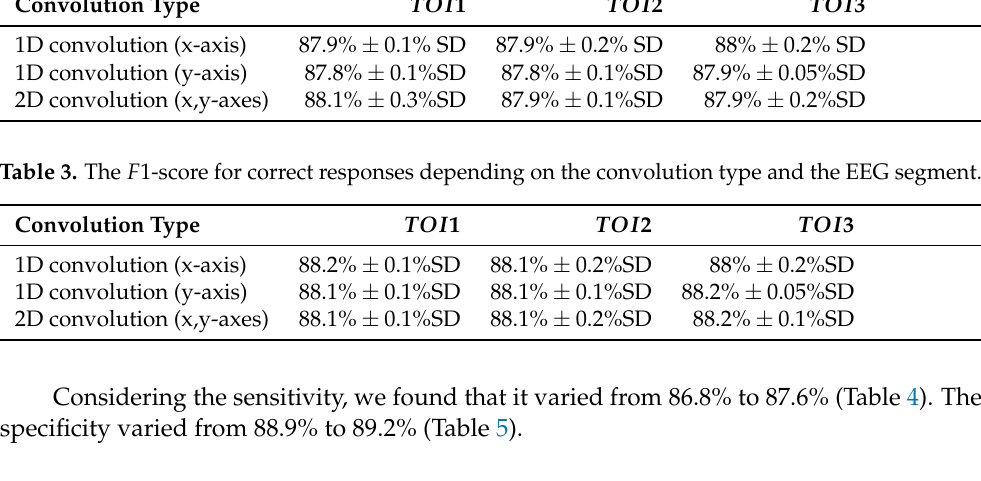
Table 2. The F 1-score for erroneous responses depending on the convolution type and the EEG segment. Convolution Type